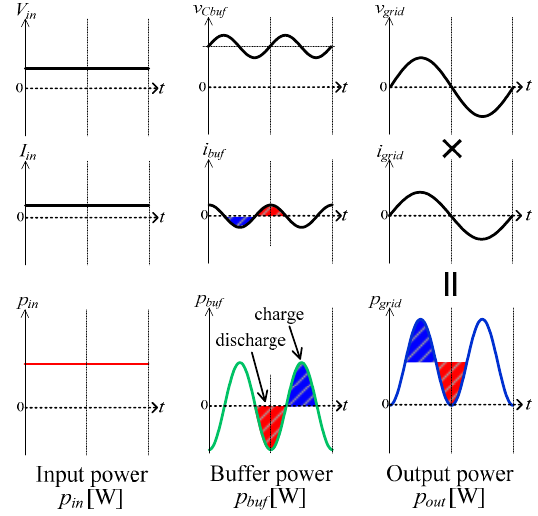
Figure 3. Principle of power decoupling between DC and single-phase AC.